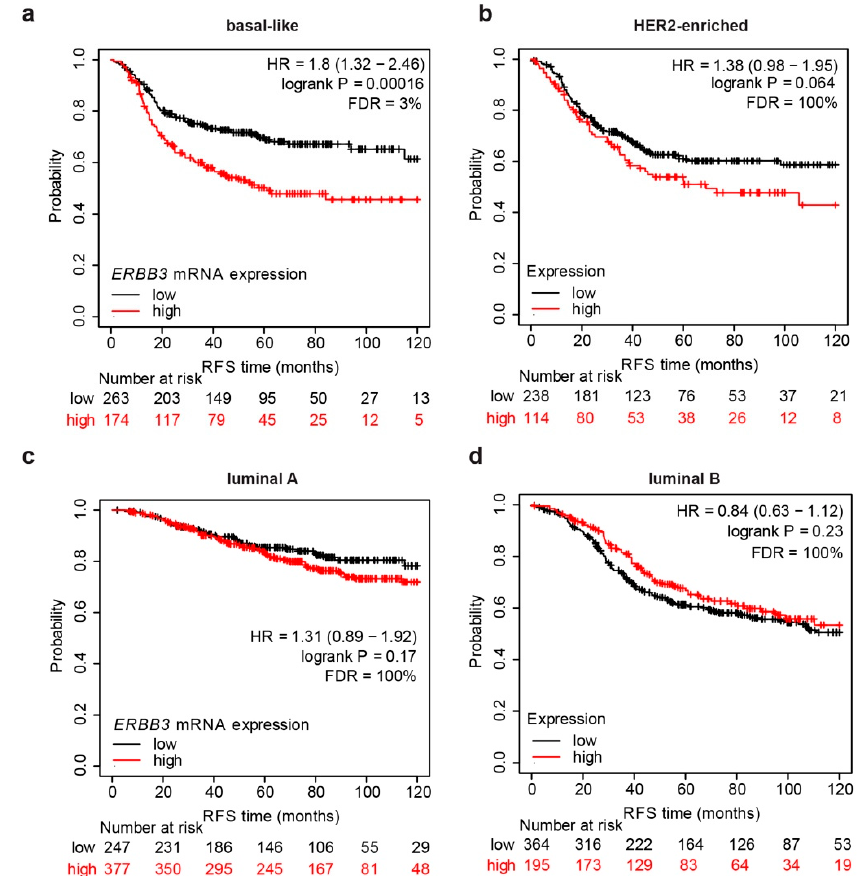
Figure 1. Relapse-free survival of breast cancer patients stratified for molecular subtypes and ERBB3 mRNA levels. ( a – d ) Relapse-free survival (RFS) of ( a ) basal-like ( n = 437), ( b ) HER2-enriched ( n = 352), ( c ) luminal A ( n = 624), and ( d ) luminal B ( n = 559) breast cancer patients stratified into two groups according to ERBB3 mRNA levels. Stratification in molecular subtypes was obtained by a prediction analysis of microarray 50 (PAM50). Data on normal-like subgroup are not provided due to a low number of patients. p -value, hazard ratio (HR), and false discovery rate (FDR) are also provided.